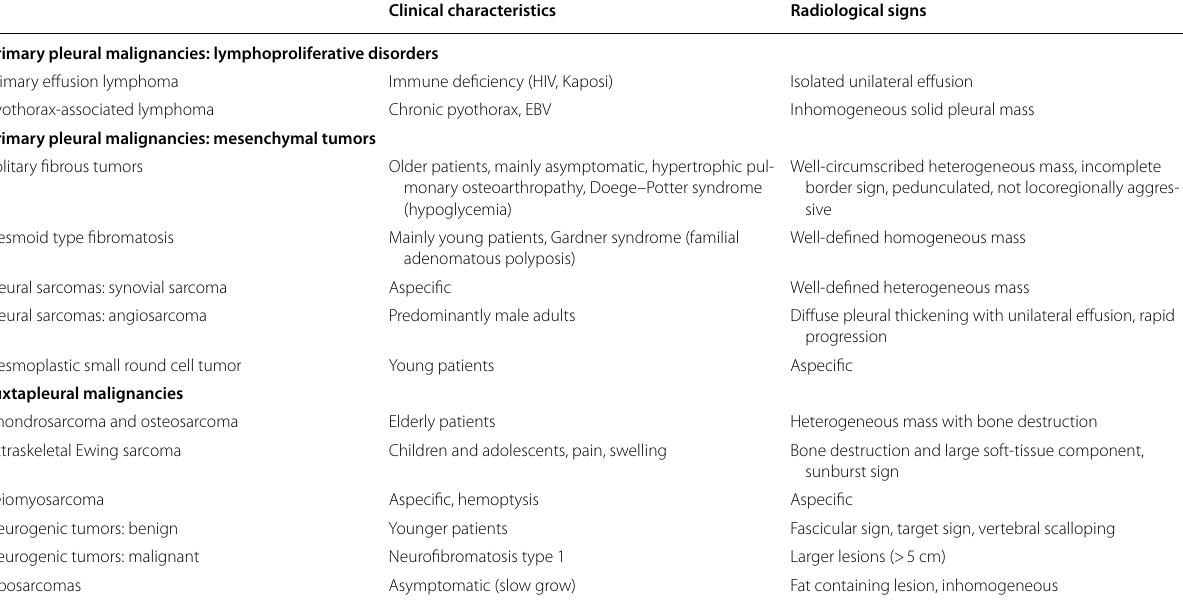
Table 1 Reviewed tumors and tumorlike conditions with an overview of the most important clinical characteristics and diagnostic signs